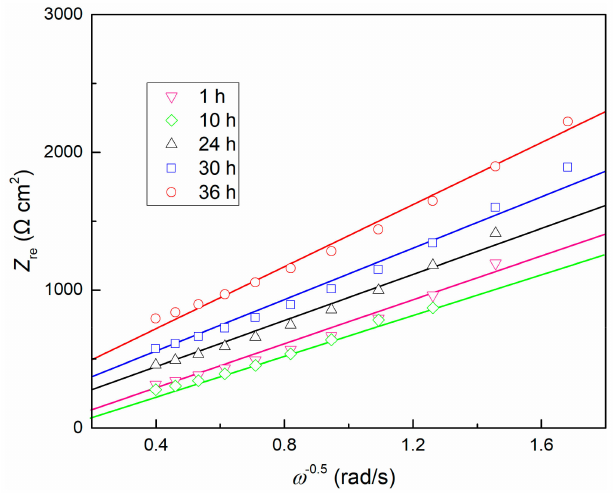
Figure 6. Dependence of Z re on ω − 1 / 2 for TC11 alloy in 0.01 M Na 2 SO 4